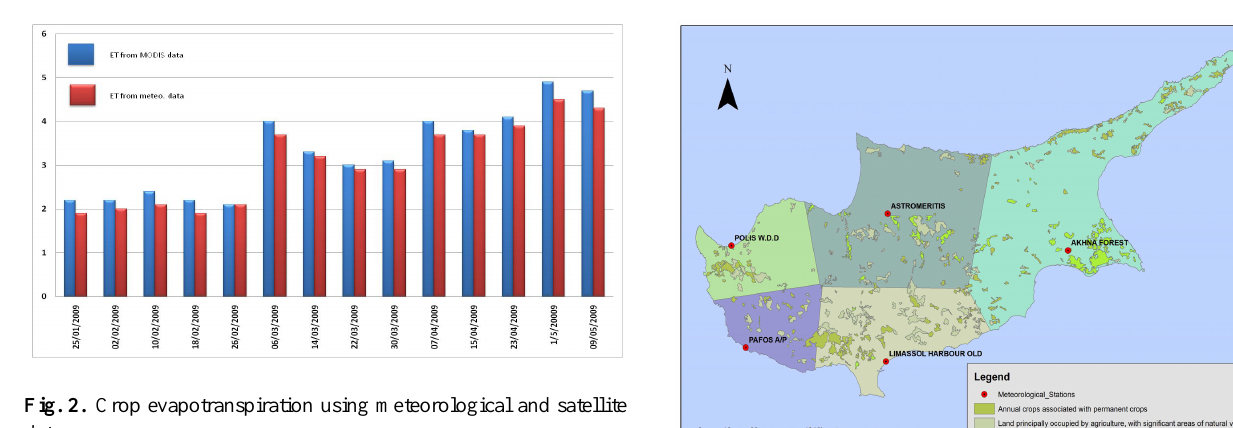
Fig 1. Landsat TM image of Cyprus: Mandria (left) and Kokkinochoria (right) area.